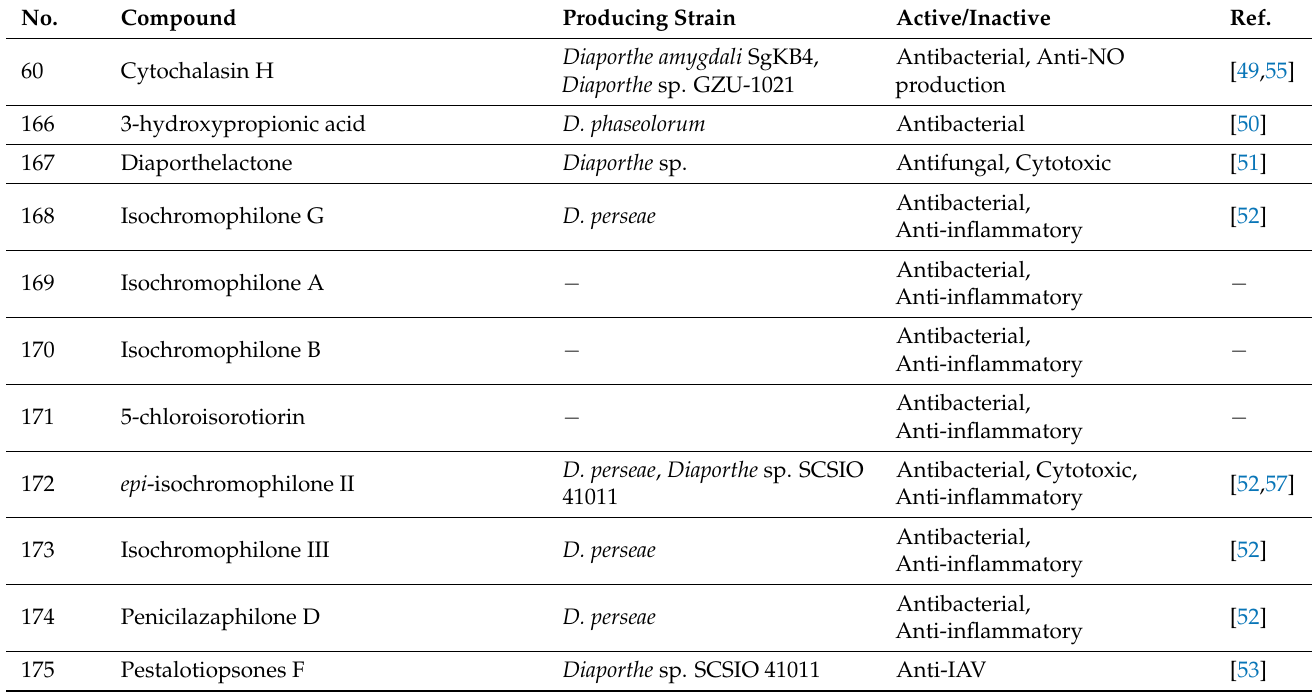
Table 2. Secondary metabolites associated with marine